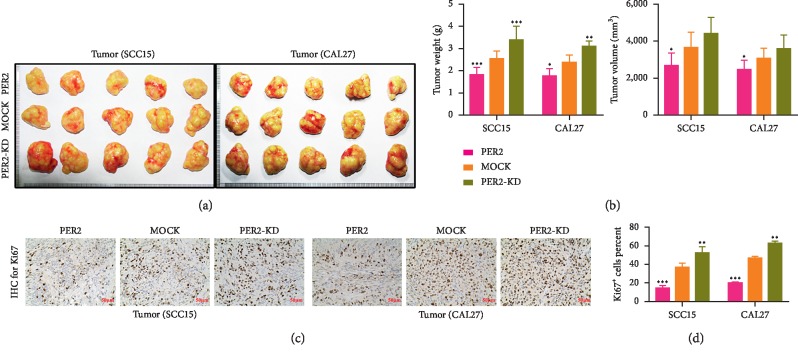
Loss of PER2 contributes to the growth of OSCC cells in vivo. (a and b) PER2 suppressed tumor growth in xenograft models. Representative images of tumors formed (a) and tumor weight and tumor volume curves (b) are presented. (c and d) Proliferation rates were measured using immunohistochemical staining for Ki67. Representative image of IHC staining (c) and statistical analysis (d). ∗P < 0.05, ∗∗P < 0.01, and ∗∗∗P < 0.001.